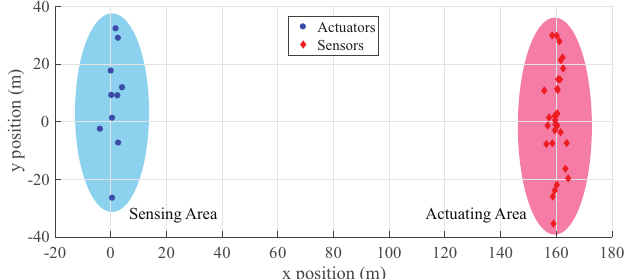
Figure 3. Node placement of the network performance